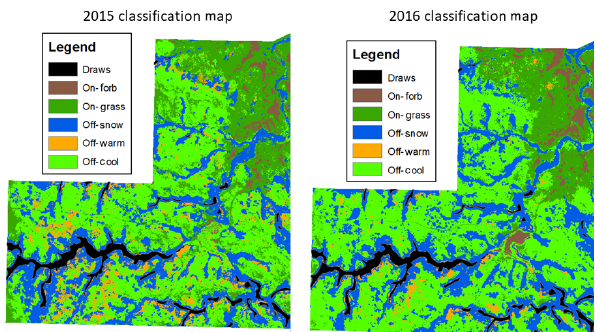
Figure 4. Random forest classification maps from 2015 and 2016 of one pasture in the study area in north central South Dakota. Plant communities on prairie dog towns are grass-dominated (On-Grass) and forb-dominated (On-Forb); plant communities in off-town areas are cool-season-grass-dominated (Off-Cool), warm-season-grass- dominated (Off-Warm), and snowberry-dominated